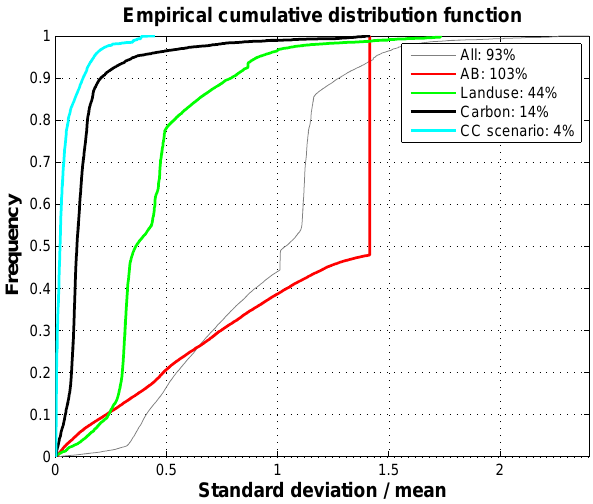
Fig. 12. Cumulative density functions (CDF) of the standard deviation of the ensemble results for daily emissions (relative to the ensemble average). CDF for the 48 estimates is indicated in gray. The CDFs for calculations with the reference configuration and one varying parameter are also indicated, with the following parameters considered individually: area burned (AB), vegetation database (landuse), biomass density (Carbon), scenario of combustion completeness (CC scenario). The numbers in the caption correspond to the average of the standard deviations (scaled by the mean values) for each ensemble set.